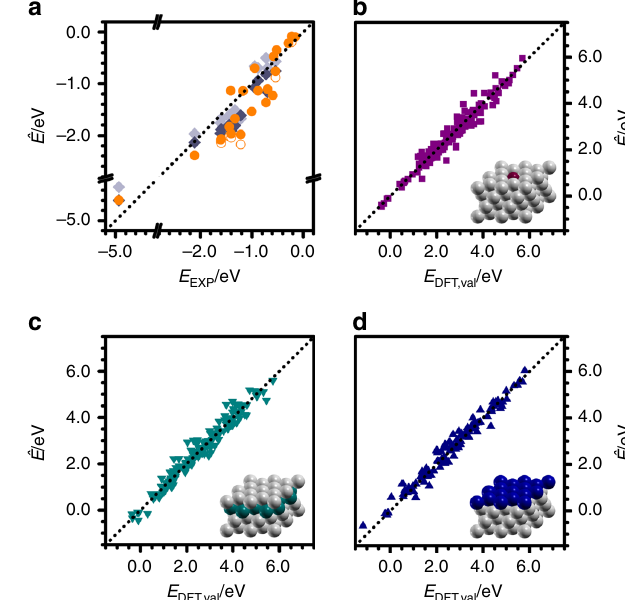
Fig. 5 Prediction of adsorption energies on metal alloys through PCR. a PCR- L1O estimates of formation energies plotted against experimental data of Supplementary Table 4 (orange circles) 53 . Open circles stand for the predicted values when coverage effects are not considered. DFT data from ref. 52 are provided as benchmark for PBE and BEEF-vdW density functionals, in dark and light gray, respectively. b Single-atom (SAA), c sub-surface (NSA- SS), and d overlayer (NSA-OL) alloys. Taking the DFT thermochemistry of 71